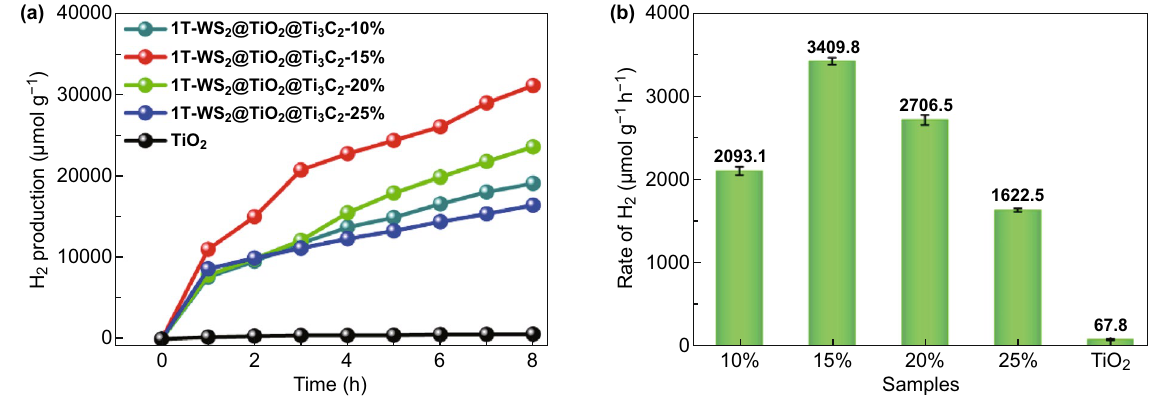
Fig. 6 a Photocatalytic H 2 production and b rate of the samples under simulated sunlight